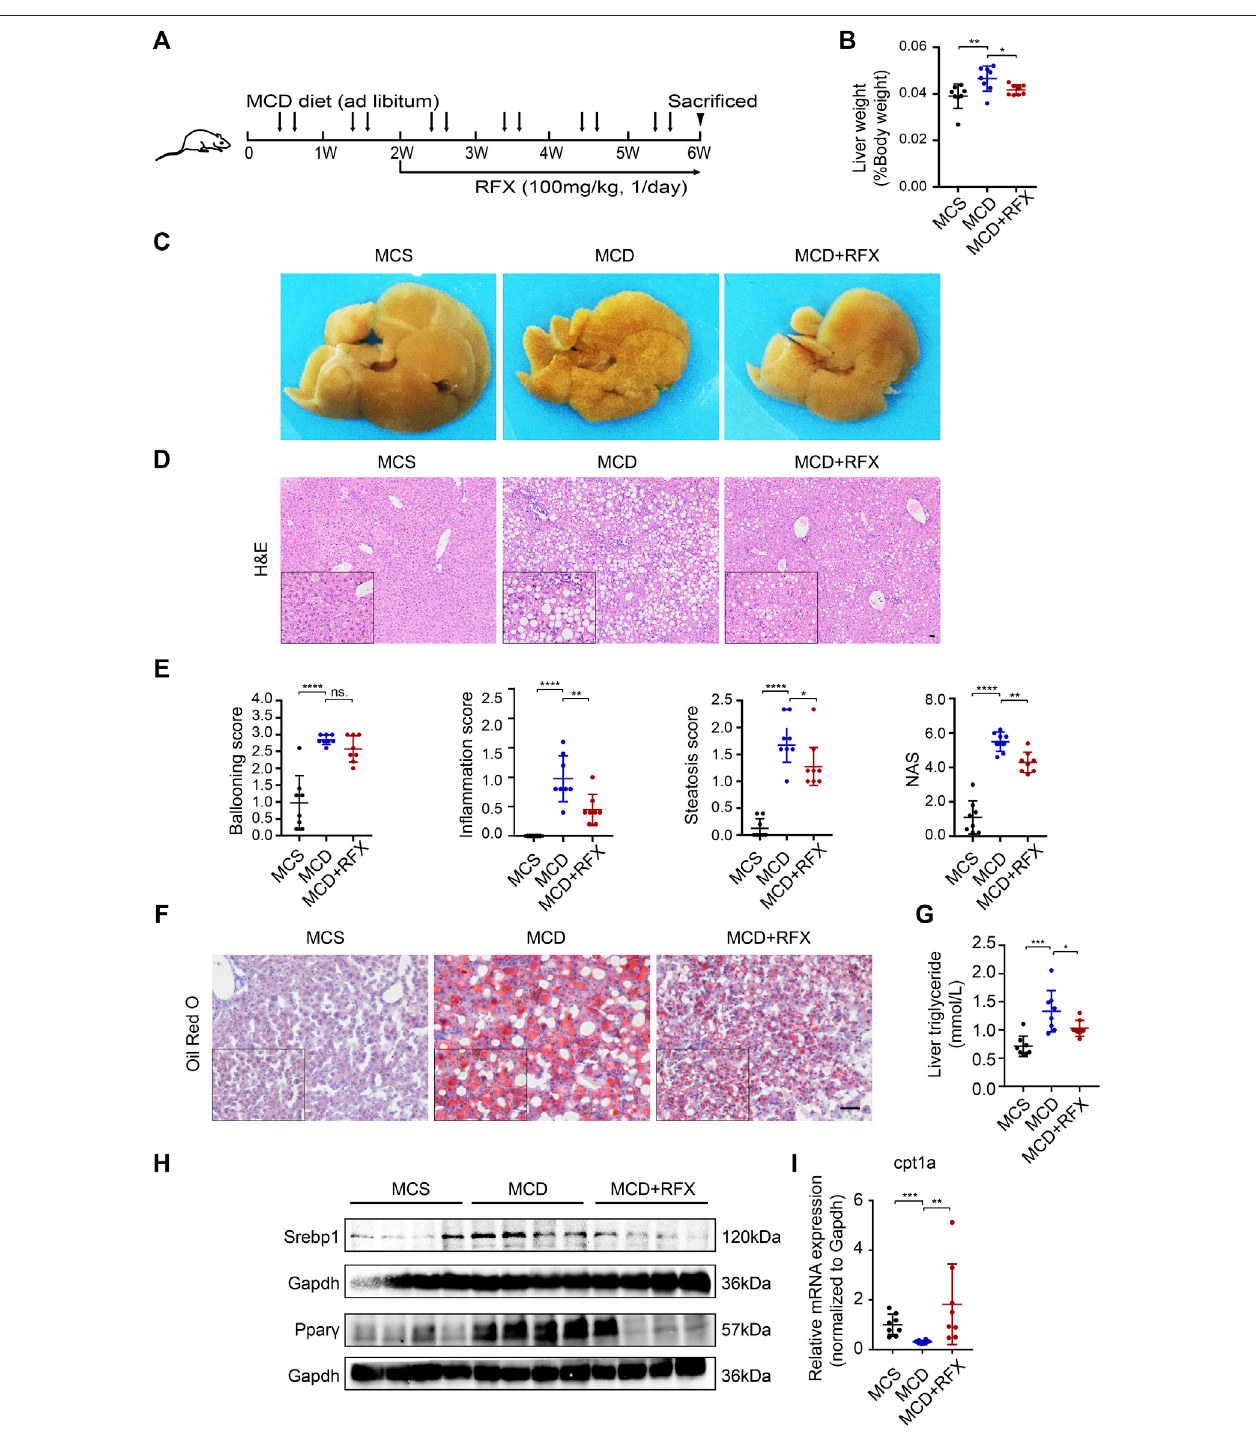
FIGURE 1 | Administration of rifaximin ameliorates experimental non-alcoholic steatohepatitis (NASH) in MCD-fed mice. (A) Schematic illustration of the experimental design. (B) Liver tobody weight ratioof C57BL/6 mice. (C) Representative macroscopic photographs oflivers for mice fed with control diet (MCS)or MCD and with rifaximin gavage. (D) Representative images of paraf fi n-embedded liver sections stained with hematoxylin and eosin (H&E). Scale bars = 200 µm. (E) Histological scores of hepatic ballooning, in fl ammation, steatosis and total NAS based on H&E staining. (F) Representative histological staining for neutral lipid (Oil Red O) in mouse livers. Scale bars = 100 µm. (G) Hepatic triglyceride levels in mice. (H) Srebp1 and Ppar γ expression in mouse liver. (I) Cpt1a mRNA levels in mouse livers. Gapdh is for normalization. Data are expressed as mean ± standard deviation. For B, E, G and I: * p < 0.05, ** p < 0.01, *** p < 0.001, **** p < 0.0001 ( p value was determined by one-way ANOVA). n = 8 mice per